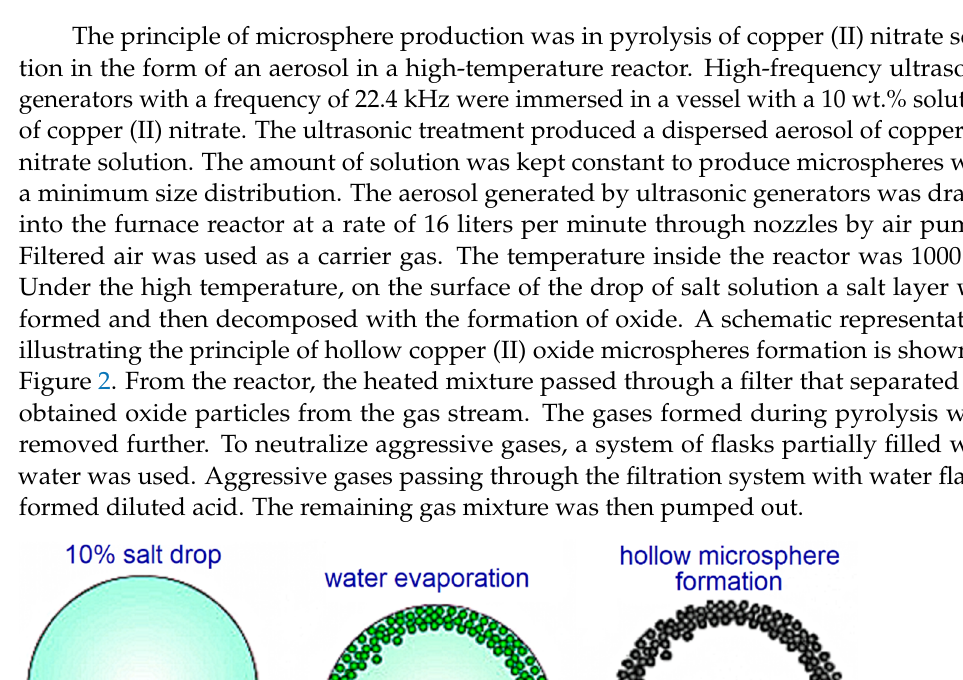
Figure 1. Scheme of synthesis of hollow copper (II) oxide microspheres.